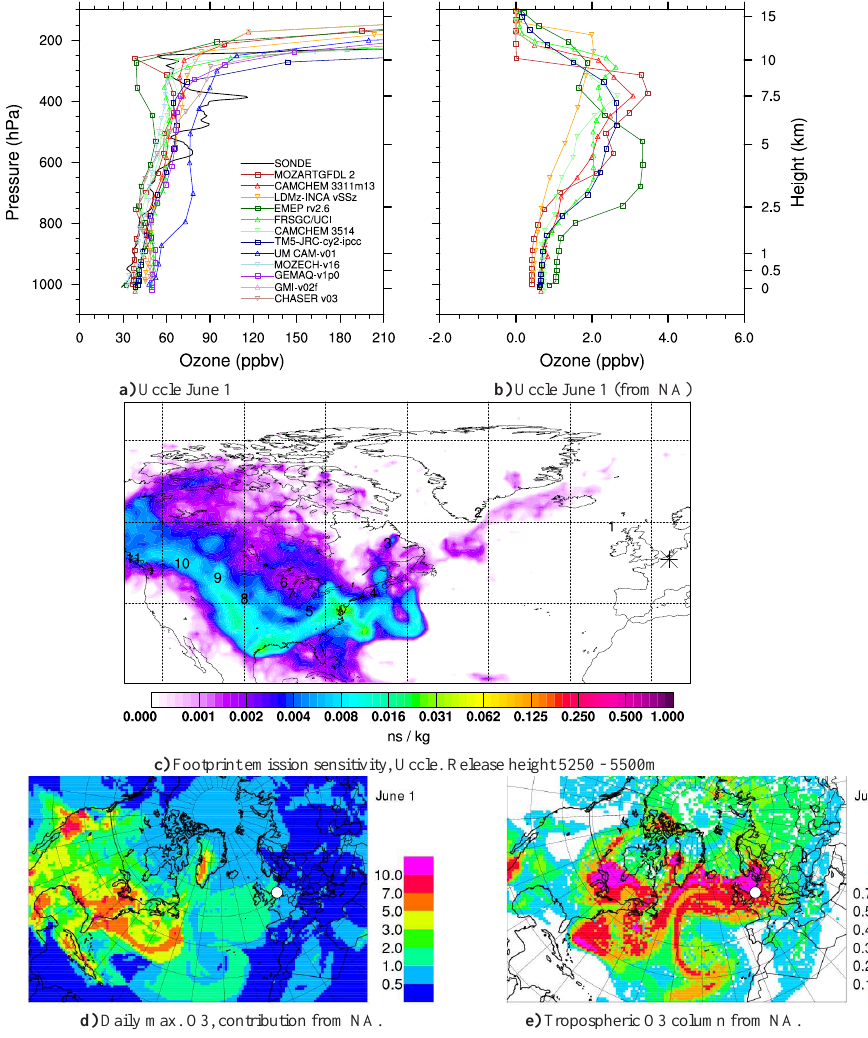
Fig. 13: All panels for June 1, 12 UTC. a) Ozone sounding and calculated vertical profiles in ppb for the 12 models listed in Table 1. b) Calculated difference SRref - SR20%NA in ppb for the 7 models, showing the effect of a 20% reduction of North American emissions. c) Footprint emission sensitivity (release height 5250 - 5500m) from Uccle in ns/kg (nanoseconds/kg). The asterisk marks the position of the ozonesonde site. d) Difference (SRref - SR20%NA) in daily maximum surface-ozone in ppb calculated with the EMEP model. e) Difference (SRref - SR20%NA) in tropospheric ozone column (DU) calculated with the EMEP model. White circle marks the position of Uccle in d) and e).